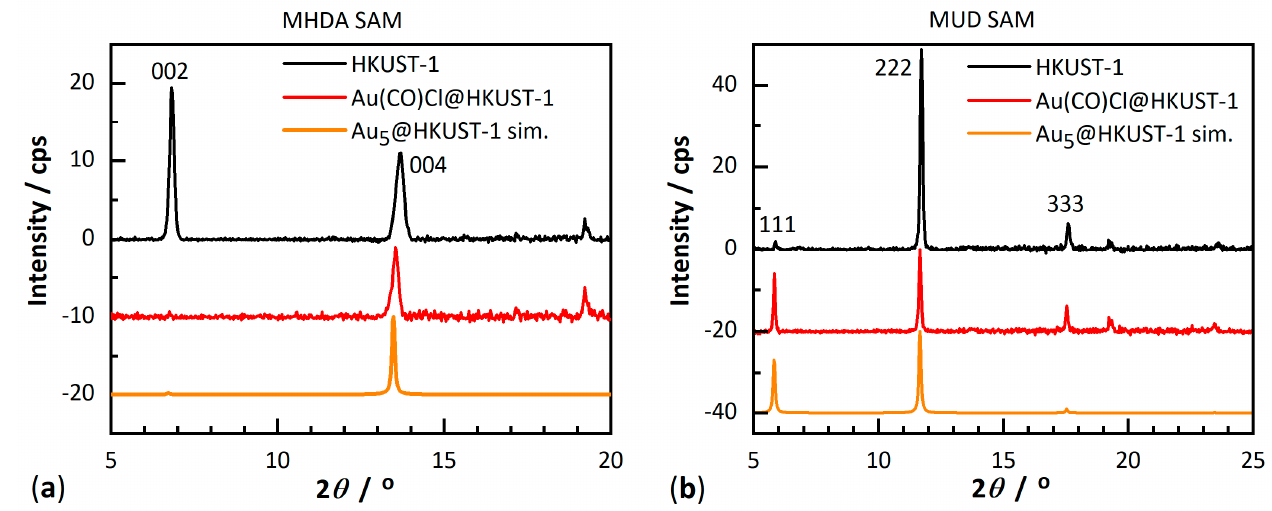
Figure 10. Experimental powder X-ray diffraction (PXRD) patterns for empty HKUST-1 SURMOF (black) and after loading Au(CO)Cl (red) into the SURMOF which was ( a ) grown on an MHDA- SAM modified Au substrate and ( b ) grown on a MUD-SAM modified Au substrate (cf. Figure 3). The yellow diffractograms are the simulation for Au 5 @HKUST-1 SURMOF with preferred [001] ( a ) and [111] ( b ) orientation. The simulated PXRD patterns have been calculated with the program MERCURY [56] using the cif file for HKUST-1 with CSD-Refcode DOTSOV, CCDC 697917 [57] and setting the March–Dollase parameter to 0.01. The reflections are designated by the Miller indices